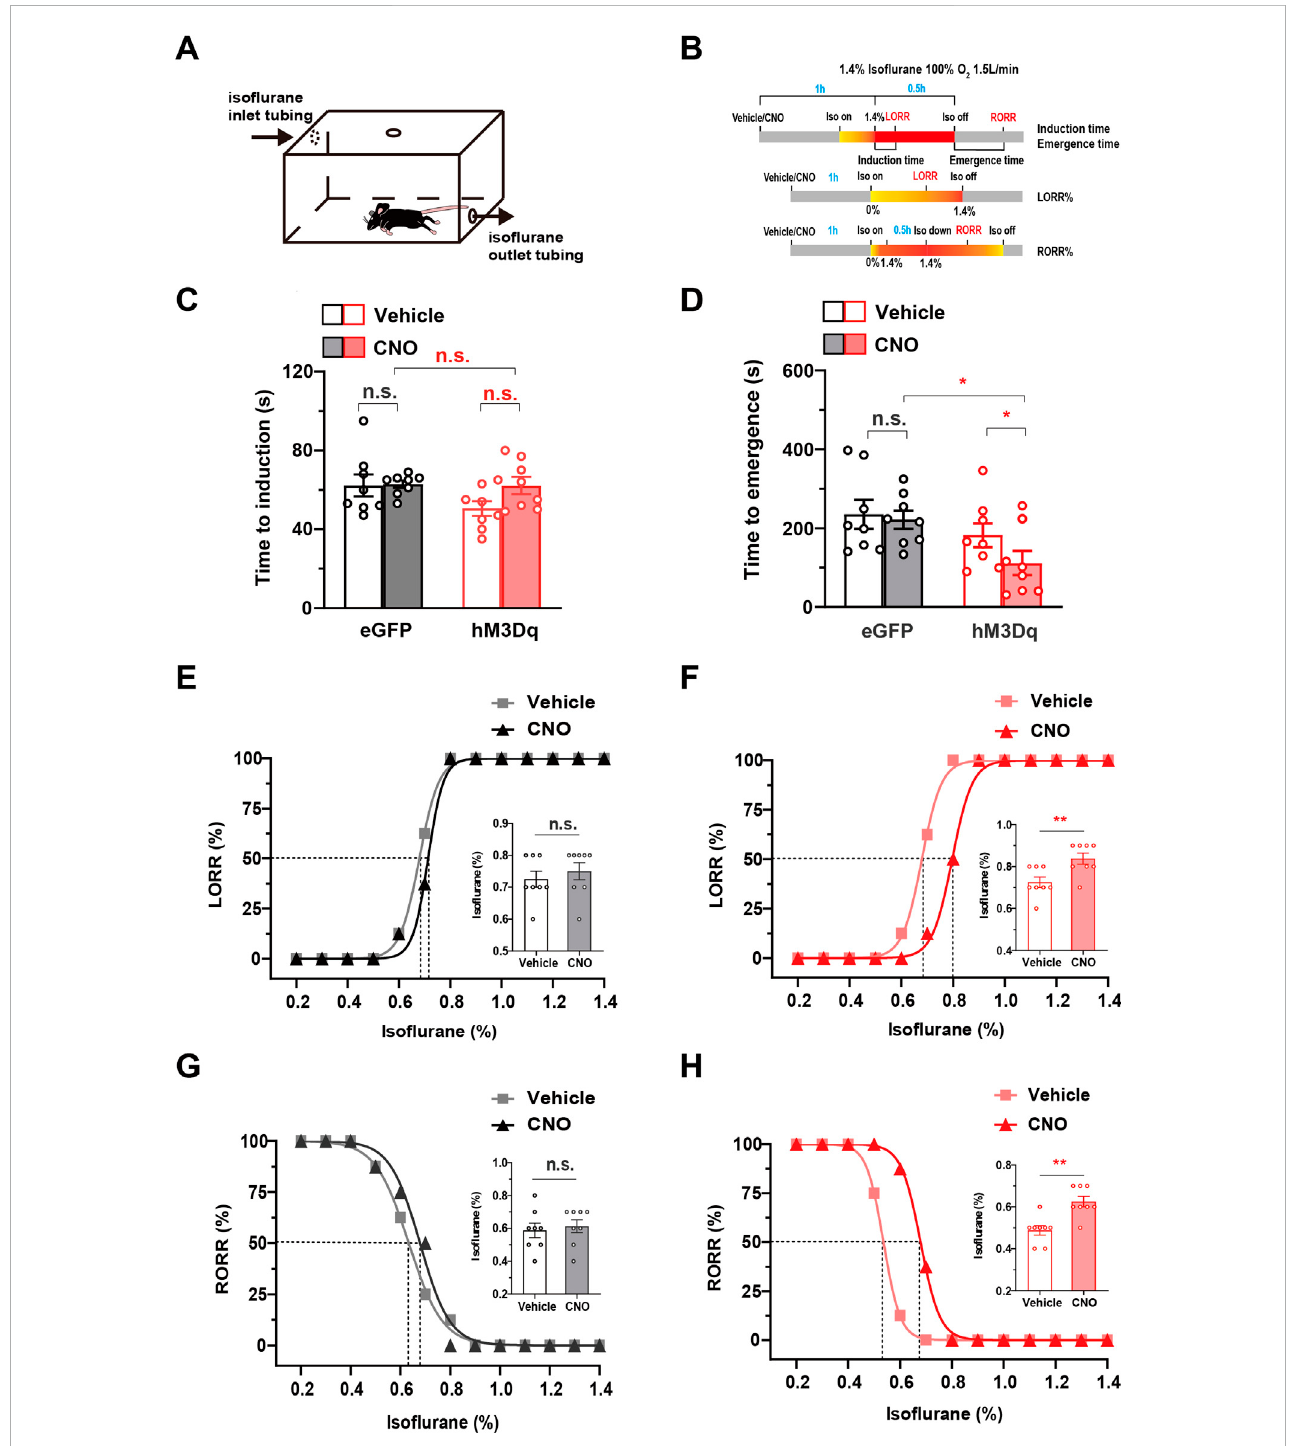
FIGURE 3 TheeffectofthechemogeneticactivationofPBNastrocytesontheinductionandemergencefromiso fl uraneanesthesia (A) SchematicdiagramofLORR or RORR observation during iso fl urane anesthesia. (B) Schematic diagram of the experimental protocol to observe the effects of activation of PBN astrocytes on LORR or RORR time under 1.4% iso fl urane anesthesia. (C) Effects of chemogenetic activation of PBN astrocytes on LORR time under 1.4% iso fl urane anesthesia. Two-way repeated-measures ANOVA ( n = 8). (D) Effects of chemogenetic activation of PBN astrocytes on RORR time under 1.4% iso fl urane anesthesia. Two-way repeated-measures ANOVA ( n = 8). (E) The dose-response curve shows the percentage of mice showing LORR as the iso fl urane concentration gradually increased after vehicleor 3 mg/kg CNO injection in eGFP group. Inset: theiso fl uraneconcentrations at which each mouse exhibited LORR are shown. Paired t -test ( n = 8). (F) The dose-response curve shows the percentage of mice showing LORR as the iso fl urane concentration gradually increased after vehicle or 3 mg/kg CNO injection in the hM3Dq group. Inset: the iso fl urane concentrations at which each mouse exhibited LORR are shown. Paired t -test ( n = 8). (G) The dose-response curve shows the percentage of mice showing RORR as the iso fl urane concentration gradually decreased after vehicle or 3 mg/kg CNO injection in eGFP group. Inset: the iso fl urane concentrations at which each mouse exhibited RORR are shown. Paired t -test ( n = 8). (H) Thedose-responsecurveshowsthepercentageofmiceshowingRORRastheiso fl uraneconcentrationgraduallydecreasedaftervehicleor3